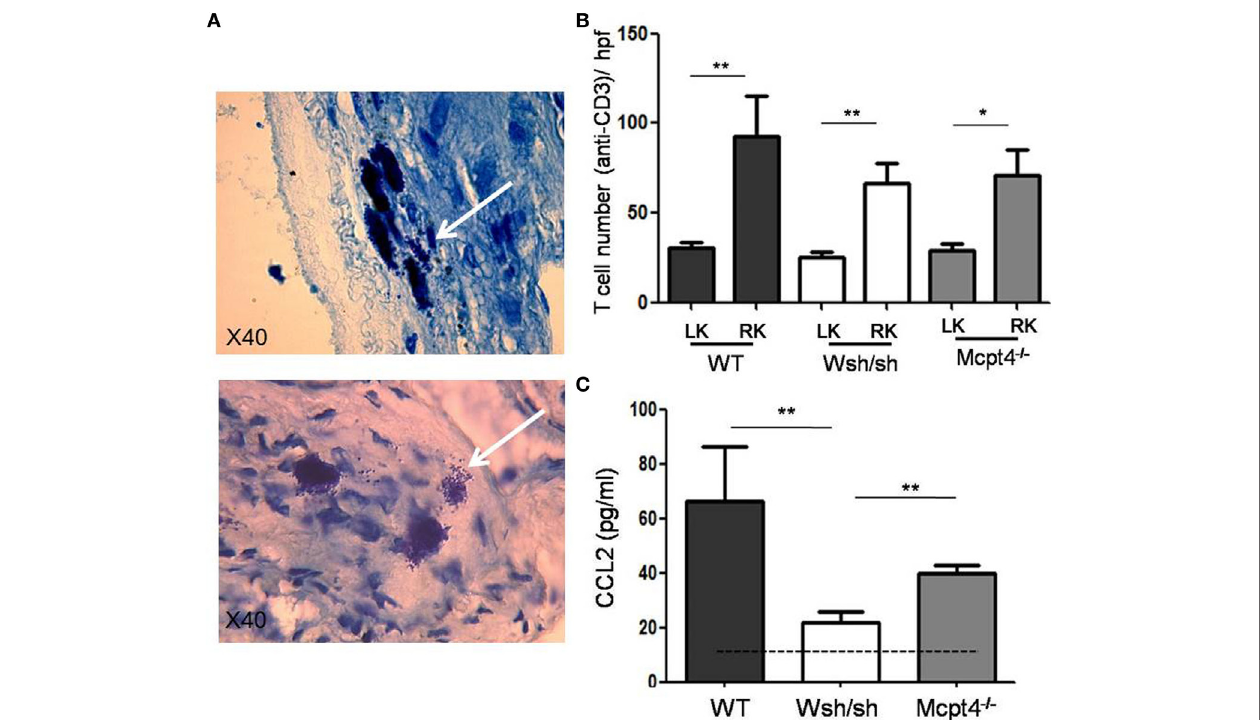
FigUre 5 | evaluation of the inflammatory response after partial unilateral ureteral obstruction . (a) Representative photomicrographs of toluidine blue-stained sections of connective tissue of renal capsules obtained from right sham and right operated kidneys of wild-type (WT) mice D75 post-surgery. Note the presence of degranulated MCs in operated kidneys (arrow). (B) Quantification of T cell infiltrate (CD3 staining) in sham and operated right kidney parenchyma of WT (16), MC-deficient (11), and MCPT4-deficient (9) mice. Data are the mean ± SEM of indicated numbers of mice, ** p ≤ 0.01 and * p ≤ 0.05. (c) Blood was drawn from sham (5), WT (6), MC-deficient (7), and MCPT4-deficient (11) mice at D75 post-surgery, and CCL2 levels were measured using an ELISA as described under Section “Materials and Methods.” Data are the mean ± SEM of indicated numbers of mice, ** p ≤ 0.01. There is a significant difference between the three strains and sham mice (Kruskal–Wallis test, p = 0.0007).